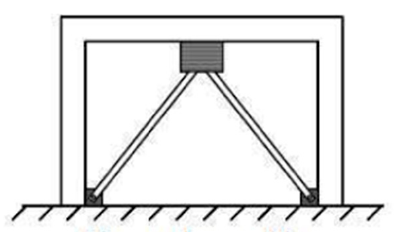
Figure 7. Addition of diagonal bracings [8].